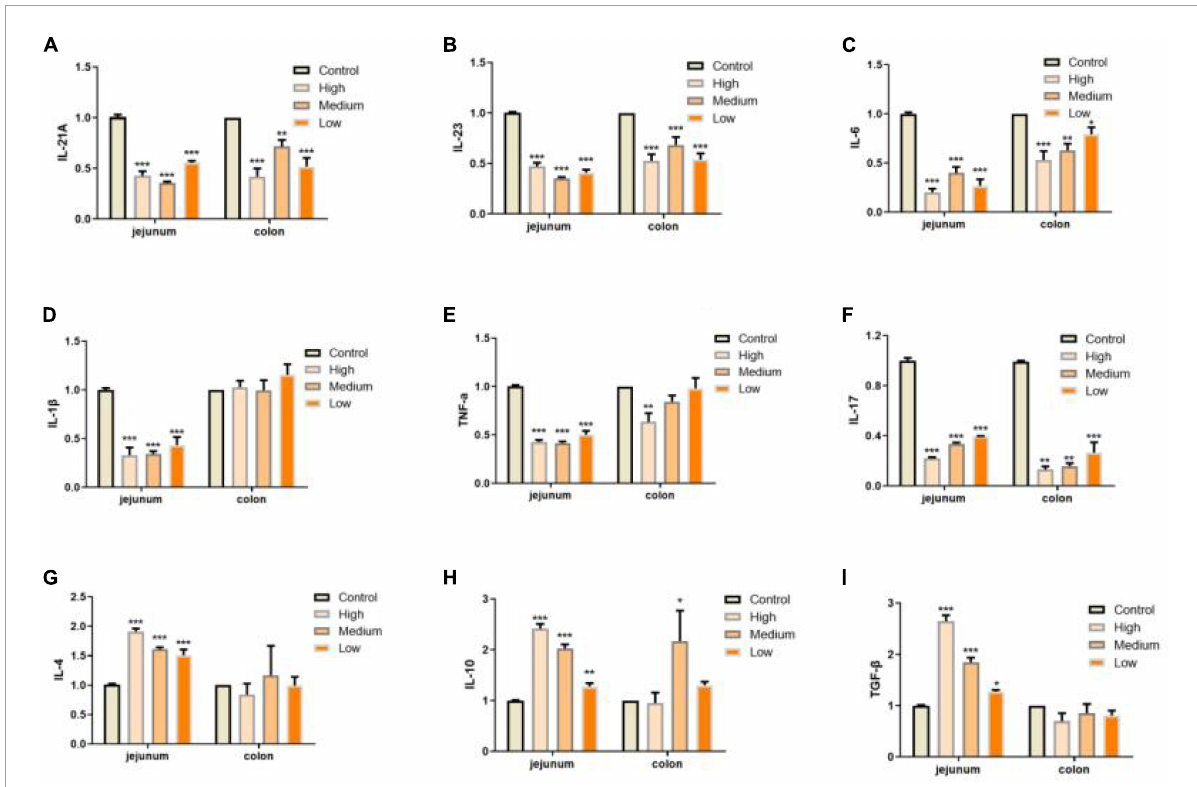
FIGURE7 PSP-NP enhances the intestinal immunity of aged mice. (A–I) Gene expressions of IL-12A, IL-23, IL-6, IL-1 β , TNF- α , IL-17, IL-4, IL-10, and TGF- β measured by qRT-PCR in jejunum and colon, respectively. PSP-NP significantly down-regulated the gene expressions of pro-inflammatory factors including IL-12A, IL-23, IL-6, IL-1 β (No significant effect in colon), TNF- α and IL-17, and up-regulated anti-inflammatory factors involving IL-4, IL-10, and TGF- β . Control indicated the control group administrated with saline, and High, Medium and Low indicated high, medium and low dose groups administrated with 200/100/50 mg/kg PSP-NP, respectively. Error bars indicated SEM. N = 8. All data were analyzed by SPSS with the one-way analysis of variance (ANOVA) by LSD test, * P < 0.05, ** P < 0.01, *** P < 0.001, compared with a control